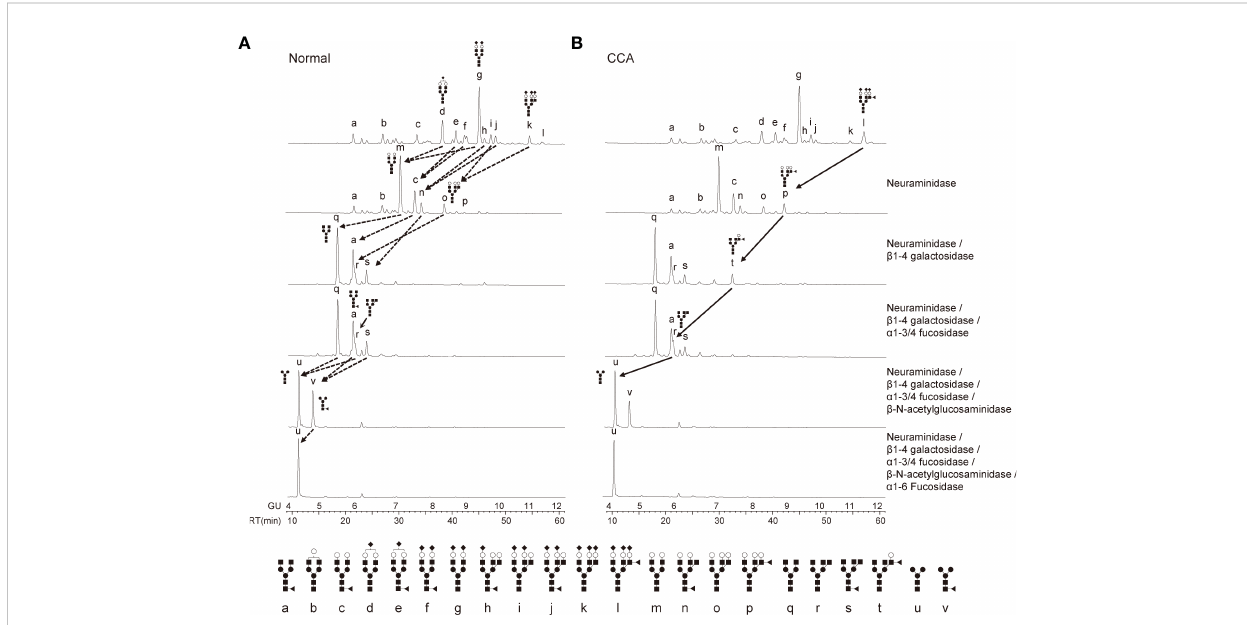
FIGURE 3 Detailed analysis of glycosylation structures in EV-Hp. (A-B) The chromatogram of 2-AB glycans extracted from EV-Hp of normal (A) and CCA (B) . Chromatograms of 2-AB glycans digested with various exoglycosidases are shown in lanes 2-6; n = 4. Glycan structures corresponding to peaks were shown below. ◼ : GlcNAc, ● : mannose, ○ : galactose, ▲ : fucose, ◆ : sialic